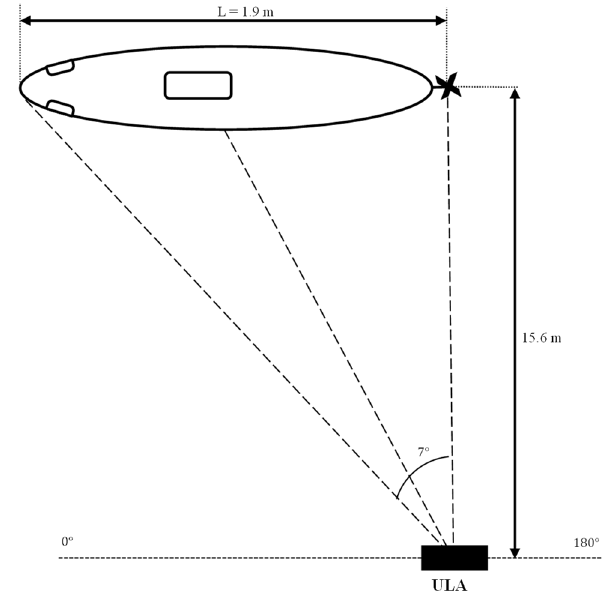
Figure 7. Top view of the layout of the experimental scene.